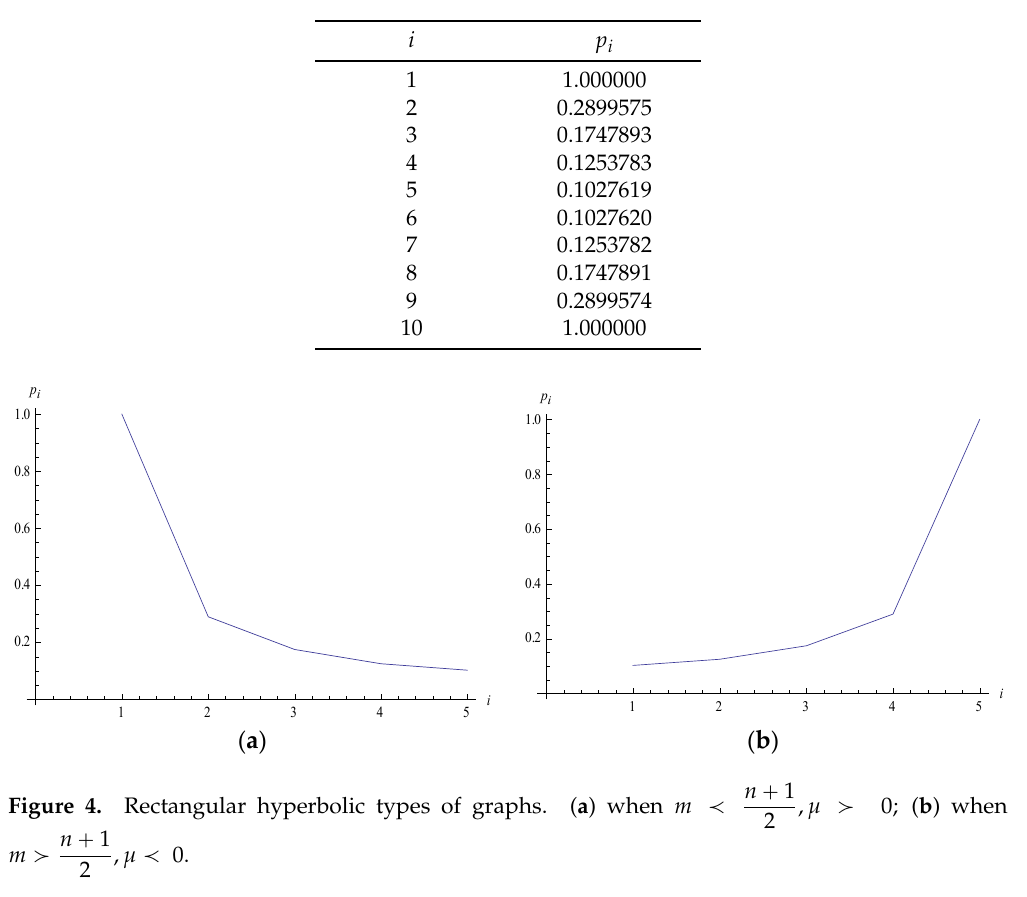
Figure 4. Rectangular hyperbolic types of graphs. ( a ) when m ă n ` 1 m ą , µ ă 2